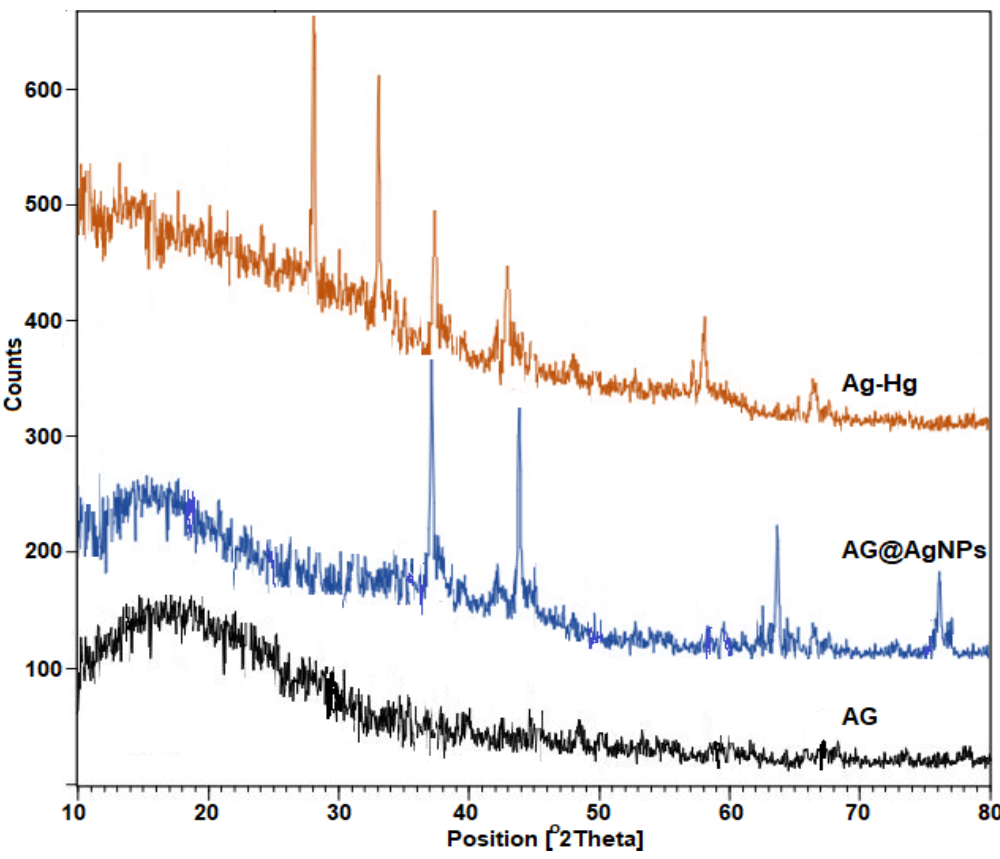
Figure -3. XRD studies of AG (black line), AgNPs@AG (blue line), and Ag − Hg (brown line). Figure 3. XRD studies of AG (black line), AgNPs@AG (blue line), and Ag − Hg (brown